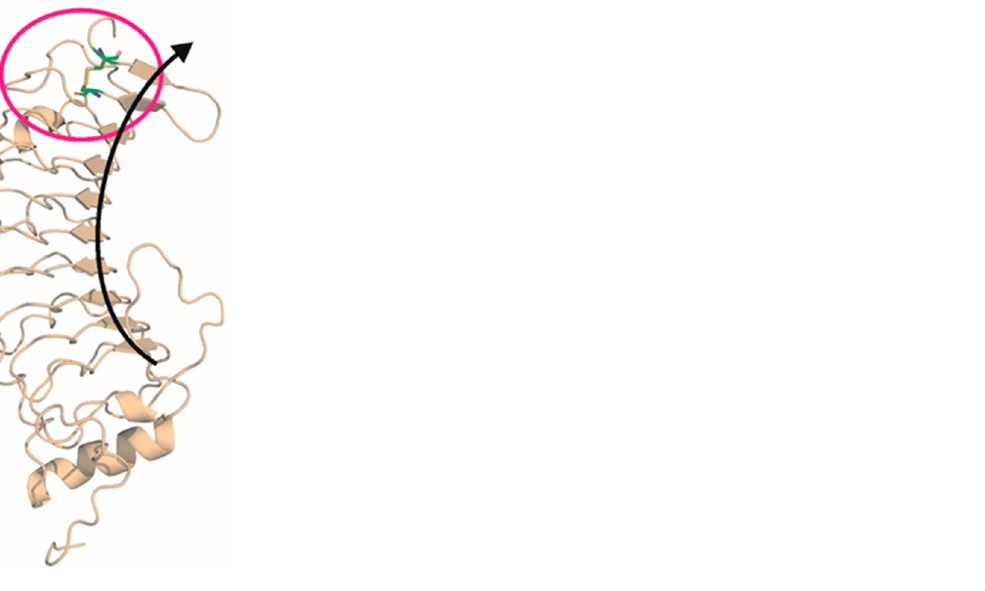
Figure 3. Human crystal structure of the N-terminal domain of GPIb α (pdb code 1p9a). Cys33 and Cys20 creating a disulfide bridge are highlighted in the magenta circle. Leucine-rich repeats folded into β -strands create an arc, which is highlighted by the black arrow. Cysteine–tyrosine substitution results in a disruption of a disulfide bond.